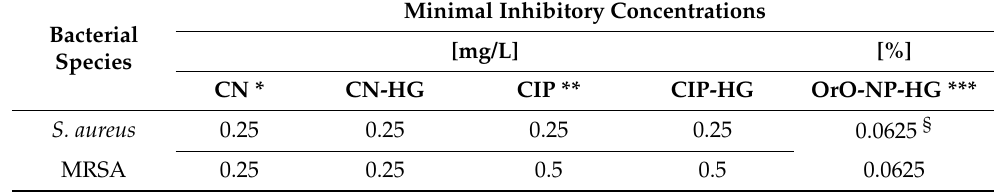
Table 2. Minimal inhibitory concentrations of hydrogels with OrO-NP, gentamicin or ciprofloxacin after single application. Bacterial Species